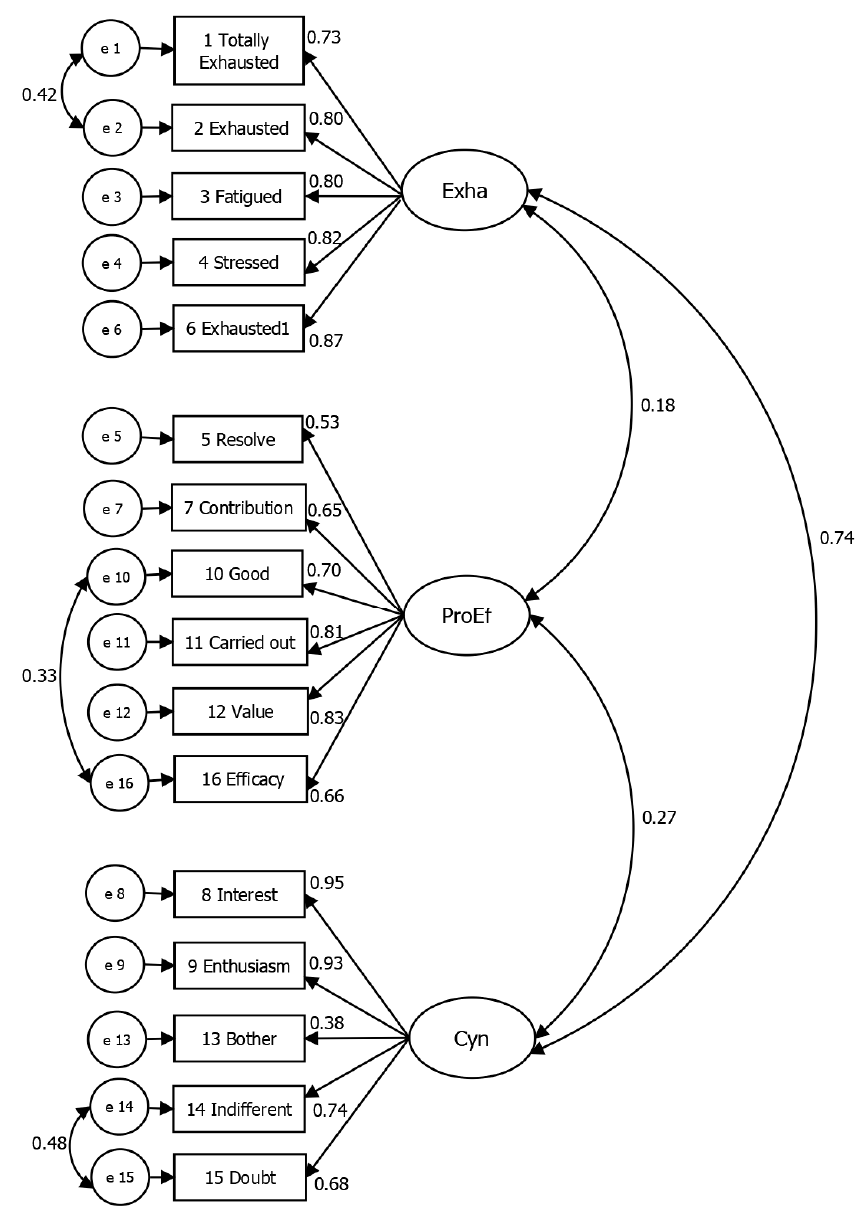
Figure 1. Model of factorial structure for MBI-GS in of middle and senior management in the maquiladora industry of the state of Baja California.